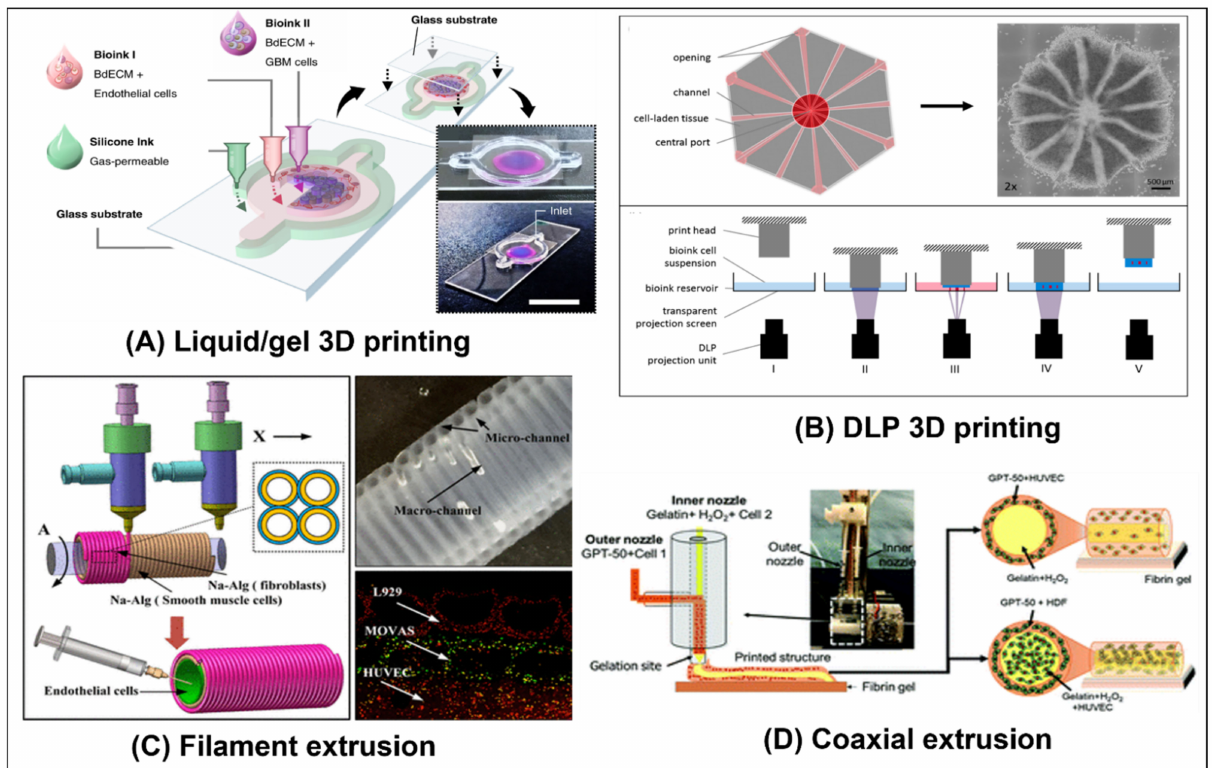
Figure 3. Methods of bioprinting: ( A ) Liquid bio-inks impregnated with different types of cells were 3D printed onto a glass slide, to create a patient specific glioblastoma-on-a-chip model. Patient derived cancer cells were printed in the chip’s center, surrounded by a layer of vascular cells. The chips were then subjected to various cancer treatments and the differences in their response reflected the differences in the clinical responses of the patients to cancer treatments [10]. Reproduced with permission from Nature Biomedical Engineering; published by Springer Nature, 2019. ( B ) Liver organoids that mimic the sinusoidal structure of liver lobules were printed using a DLP 3D printer. The lobules contained a perfusable network [39]. Reprinted with permission from Genes; published by MDPI, 2019. ( C ) Micro-tubes made from cell-laden alginate gels were extruded, using a coaxial nozzle, onto a rotating glass rod to create a macro-vessel. The lumen of the macro vessel was then coated with collagen. Finally, HUVECs were introduced into the macro channel. The result is a vessel with multiple layers of different cell types (fibroblasts, smooth muscle cells, and endothelial cells). The outer micro-channels could also be perfused [42]. Reprinted with permission from 3D Bioprinting of Vessel-like Structures with Multilevel Fluidic Channels, ACS Biomater. Sci. Eng., vol. 3, no. 3, pp. 399–408. Copyright 2017, American Chemical Society. ( D ) A vascular vessel was extruded onto a fibrin gel biopaper using a coaxial nozzle and bio-inks containing cells. Vessels could be printed with HUVECs embedded in the walls and a sacrificial core to create a perfusable lumen. Alternatively, vessels could be printed with human dermal fibroblasts (HDFs) embedded in the walls and a core containing gelatin laden with HUVECs [37]. Reproduced with permission from Biomaterials Science; published by RSC,